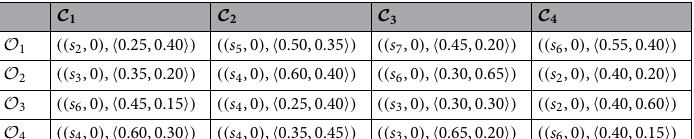
Table 5. q-ROPFL data provided by D 1 .